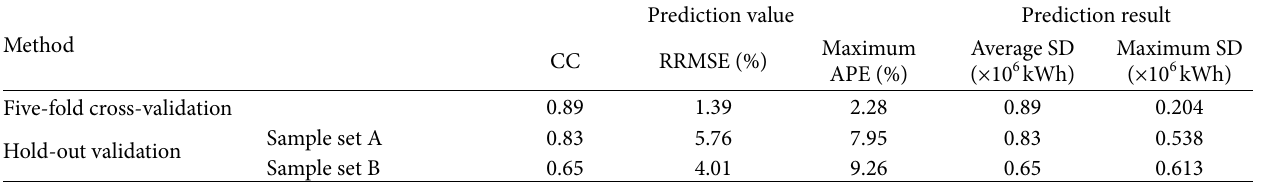
Table 7: Comparison between five-fold cross-validation method and hold-out validation method.